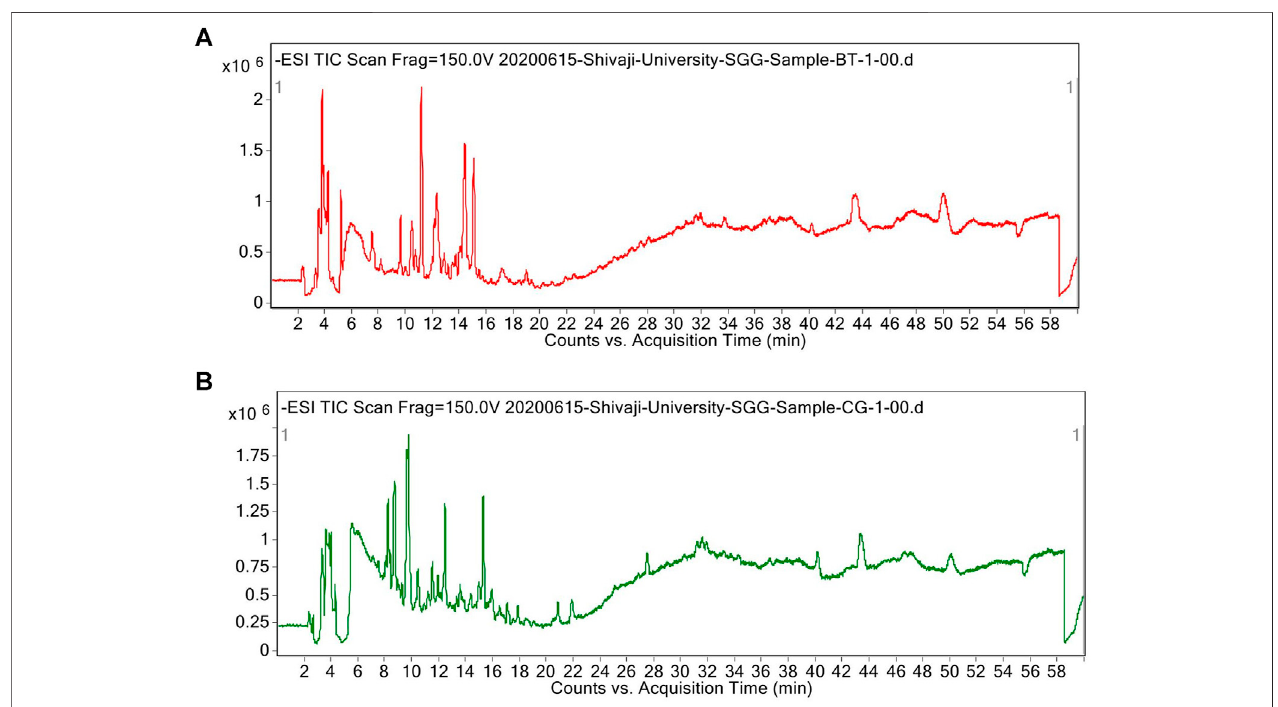
FIGURE 6 | Total ion chromatograms (TICs) of methanol extract of B. terminalis leaves (A) and C. grandi fl orus leaves (B) .